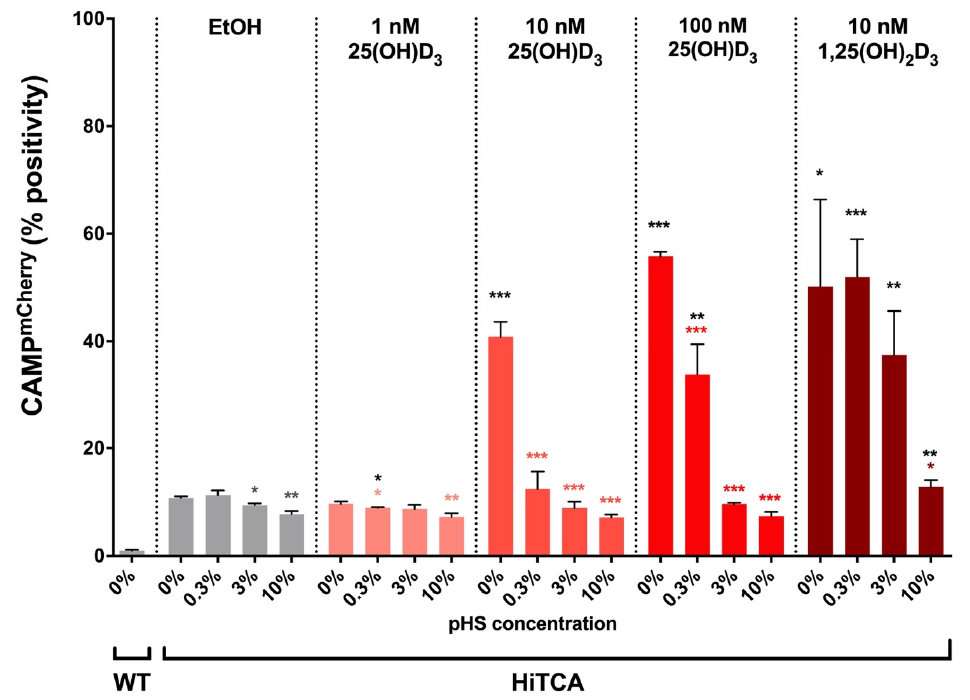
Figure 5. Pooled human serum dose-dependent attenuation of HiTCA CAMP mCherry response. HiTCA cells were incubated in RPMI, EtOH (equal volume as vitamin D metabolite solvent), vitamin D metabolites (1 nM 25(OH)D 3 , 10 nM 25(OH)D 3 , 100 nM 25(OH)D 3 , 10 nM 1,25(OH) 2 D 3 ), and pooled human serum (pHS; 0%, 0.3%, 3%, 10%) at 37 °C for 24 h prior to flow cytometry analysis. EtOH-treated WT cells were gated to be 1% CAMP mCherry positive. Therefore, all non-WT columns represent the percentage of 10,000 live-gated single-cells that express CAMP mCherry above the WT control levels. Each column represents n = 3 biological replicates ± SD. Black asterisks represent significant differences (* p < 0.05, ** p < 0.01, *** p < 0.001) between vitamin D metabolite-treated HiTCA cells and their EtOH equivalent with the same pHS exposure. Colored asterisks represent significant differences (* p < 0.05, ** p < 0.01, *** p < 0.001) between 0% pHS-treated HiTCA cells and non-zero pHS-treated HiTCA cells of the same vitamin D metabolite treatment group.